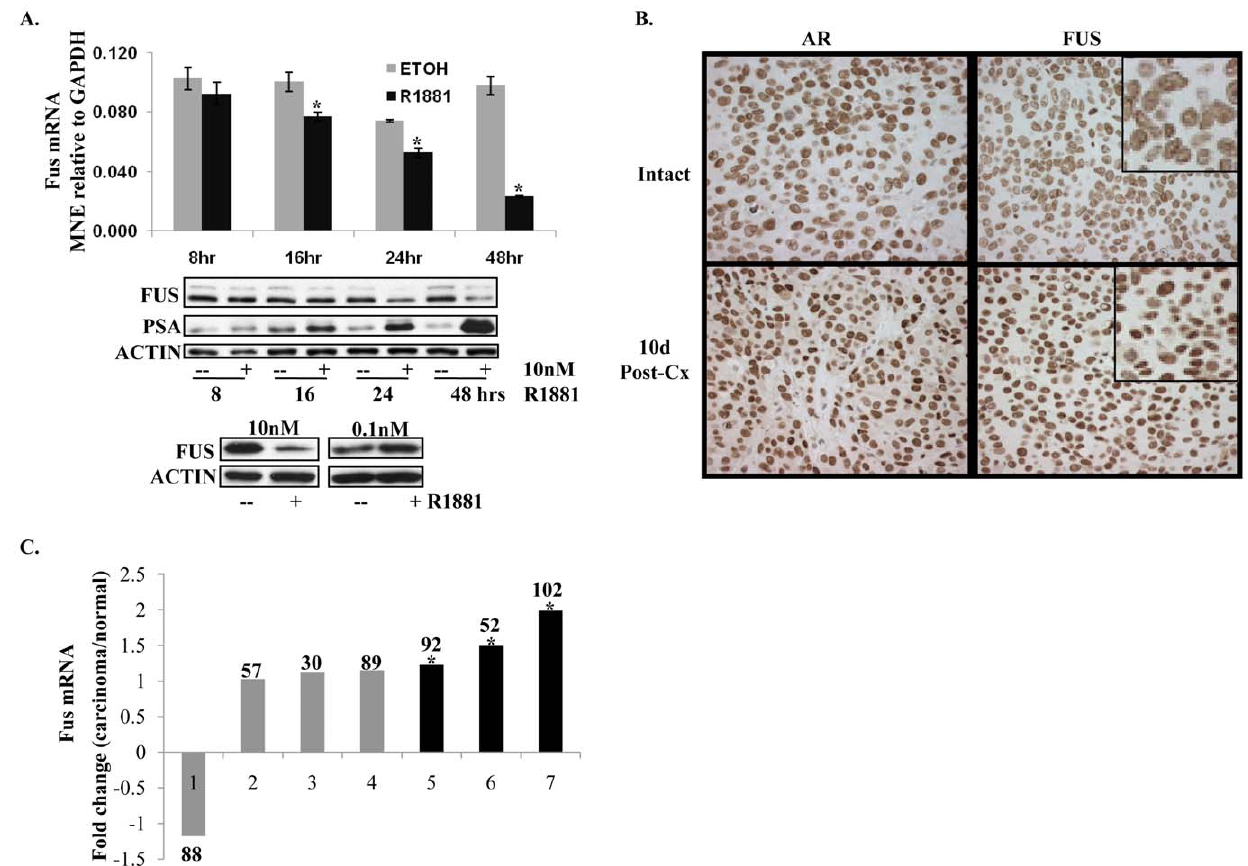
Figure 7. Regulation of FUS expression. ( A ) FUS mRNA levels in response to androgen treatment. Upper panel: FUS expression was measured by qRT-PCR in LNCaP cells treated with 10 nM R1881 for the indicated time points. Middle panel: western blot analysis of levels of FUS, PSA and Actin proteins at the indicated time points. Lower panel: western blot analysis of levels of FUS protein in LNCaP cells that were treated with 10 nM versus 0.1 nM for 48 hrs. Error bars=mean 6 standard deviation. *P , 0.05, n=3. ( B ) FUS levels in response to hormonal status in vivo . LNCaP xenografts harvested from intact (non-castrated) and castrated mice (10 days post-castration) were stained for FUS and AR proteins. ( C ) FUS levels in clinical prostate cancer versus corresponding benign tissue. Levels of FUS mRNA in clinical samples of prostate carcinoma versus normal prostatic tissue were re-analysed from previously obtained data sets using Oncomine. Black bars indicate studies where FUS was significantly overexpressed in cancer versus benign tissue. *P , 0.05.